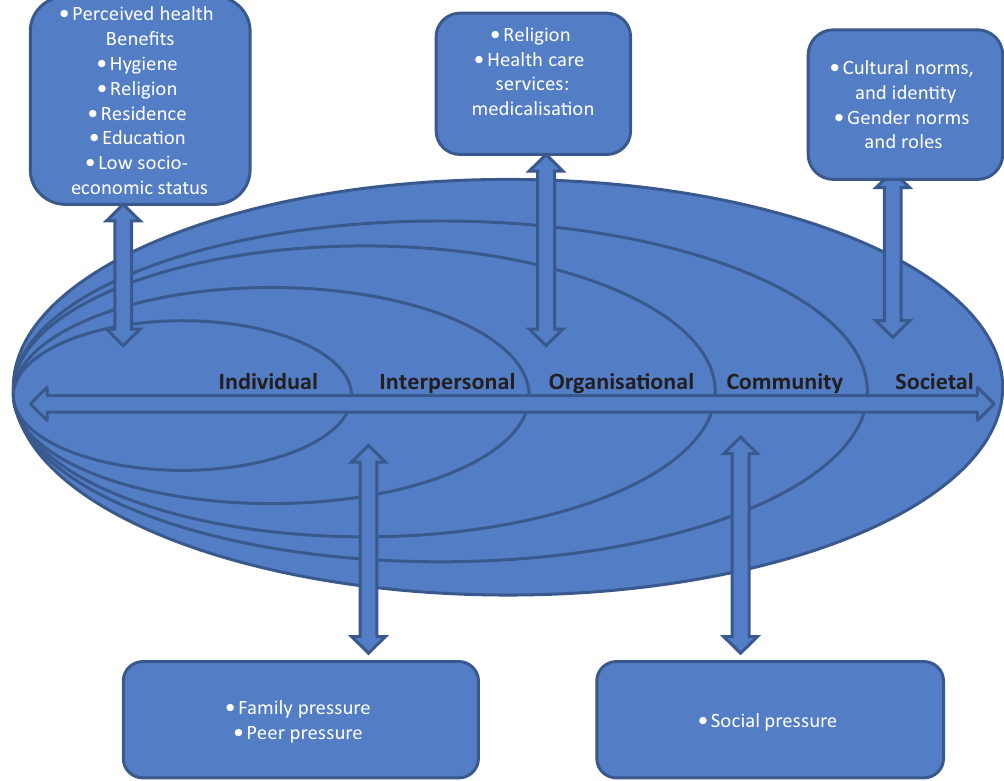
Figure 4. Illustrating a socio-ecological model of the underlying reasons/factors of FGM. Adapted from: Poundstone et al. [40].